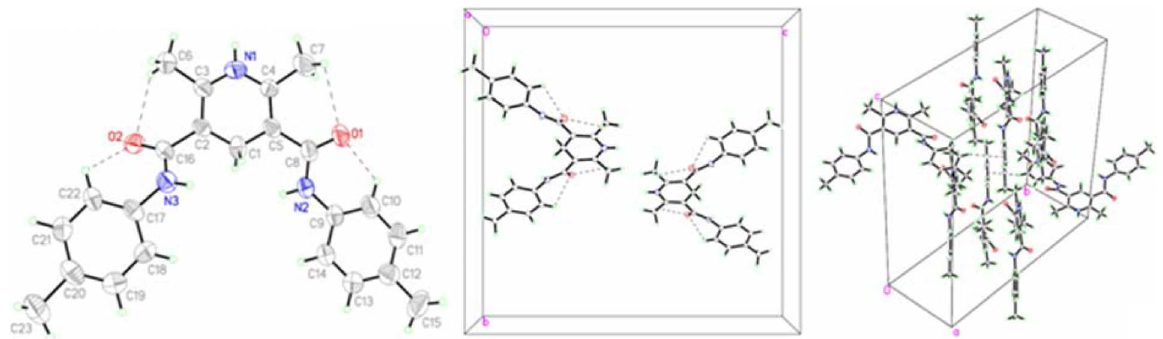
Figure 3. Crystal structure of b.